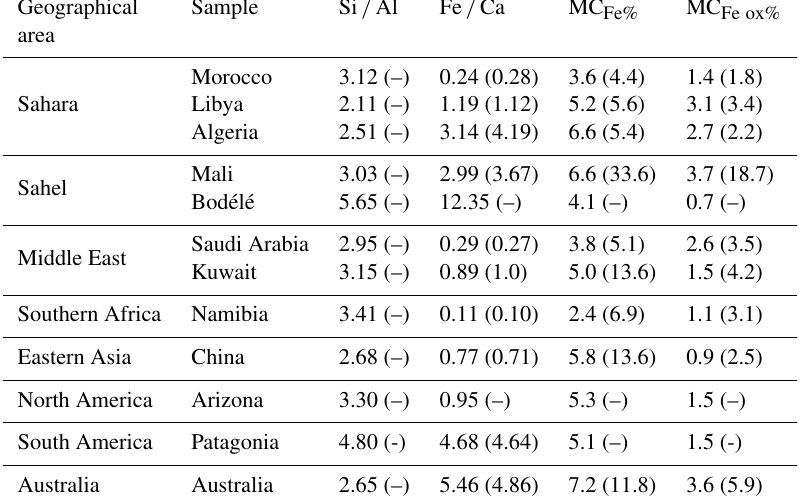
Table 3. Chemical characterization of the dust aerosols in PM 10 . 6 and PM 2 . 5 (in parentheses) size fractions. Columns 3 and 4 give the Si / Al and Fe / Ca elemental ratios obtained from X-ray fluorescence analysis. The uncertainty of each individual value is estimated to be 10%. Column 5 shows MR Fe% , the fractional mass of elemental iron with respect to the total dust mass concentration (uncertainty 10%). Column 5 reports MR Fe% , the mass fraction of iron oxides with respect to the total dust mass concentration (uncertainty 15%). For PM 2 . 5 the determination of the Si / Al ratio is impossible due to the composition of the filter membranes